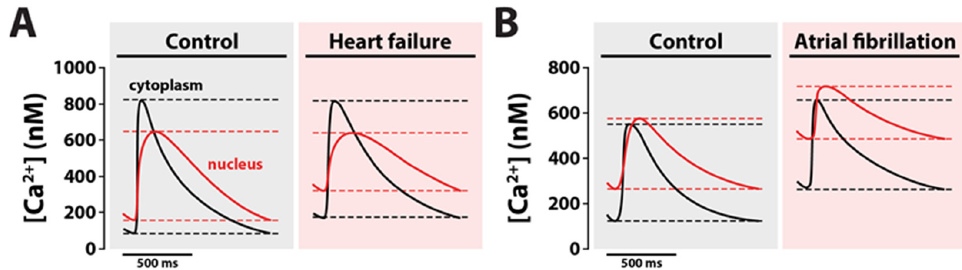
Figure 2. Averaged original recordings of nucleoplasmic (red) and cytoplasmic (black) Ca 2+ transients from isolated cardiomyocytes. ( A ) Averaged nucleoplasmic (red) and cytoplasmic (black) Ca 2+ transients of 1 Hz-stimulated isolated cardiomyocytes from sham-operated control mice (grey panel) and mice 7 weeks after transverse aortic constriction (TAC) intervention to induce pressure-overload mediated hypertrophy and heart failure (pink panel). TAC increased both cytoplasmic and nuclear diastolic Ca 2+ concentration ([Ca 2+ ] cyto and [Ca 2+ ] nuc , respectively), decreased Ca 2+ transient amplitude and prolonged time to peak and time from peak [Ca 2+ ] to 50% decline. ( B ) Averaged nucleoplasmic (red) and cytoplasmic (black) Ca 2+ transients of 1 Hz-stimulated isolated canine atrial cardiomyocytes from healthy controls (grey panel) and dogs subject to 1 week of atrial fibrillation pacing protocol (600 bpm) prior isolation (pink panel). [Ca 2+ ] nuc averages 55% higher in AF vs. CTL with reduced nucleoplasmic Ca 2+ transient amplitude and significantly increased time to peak and time from peak [Ca 2+ ] nuc to 50% decline. Adapted with permission from Refs. [28,107]. 2023, Wolters Kluwer Health, Inc., Philadelphia, USA.